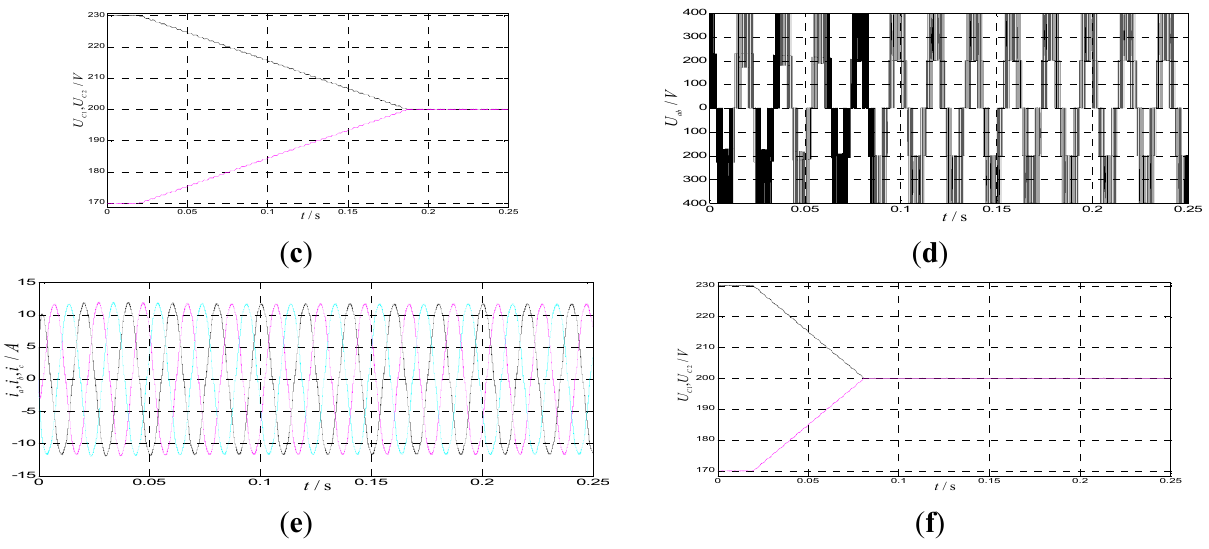
Figure 3. Simulation results of balancing DC-link capacitors voltage; ( a ) balancing process of line-to-line voltage in VSVM; ( b ) three phase currents in VSVM; ( c ) balancing process of DC-link capacitors voltage in VSVM; ( d ) balancing process of line-to-line voltage in VVSVM; ( e ) three phase currents in VVSVM; ( f ) balancing process of DC-link capacitors voltage in